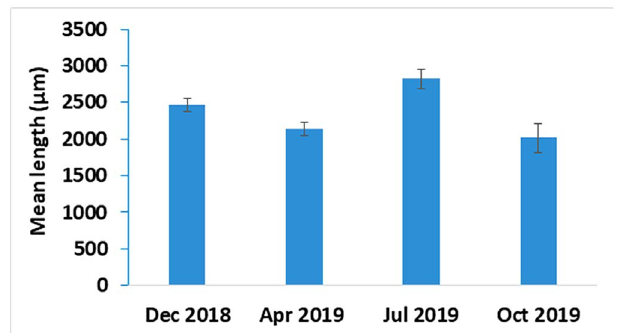
Figure 9. Mean trunk length of females of acanthocephalan Acanthogyrus ( Acanthosentis ) cf. tilapiae in Coptodon guineensis at Sebkha Imlili (December 2018: n = 41; April 2019: n = 42; July 2019: n = 47; October 2019: n = 50). Worms were signi fi cantly smaller in April and October compared to December and